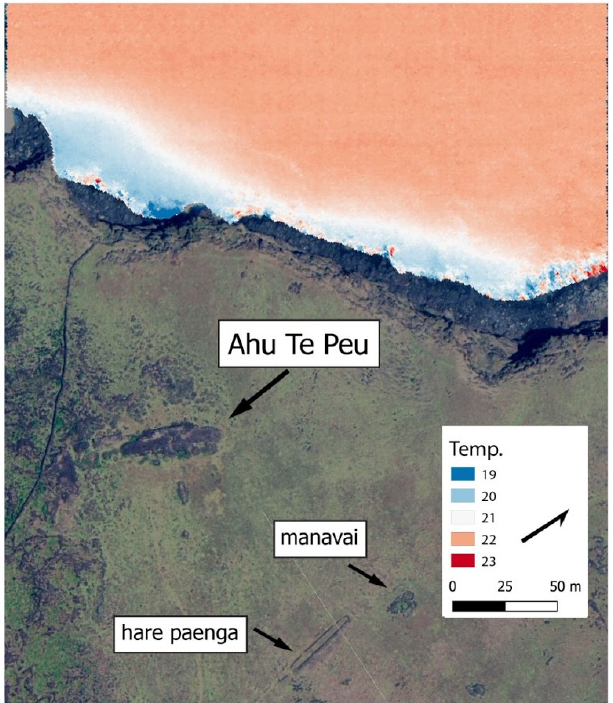
Figure 6. Thermal image of submarine groundwater discharge at Te Peu on the northwest coast.